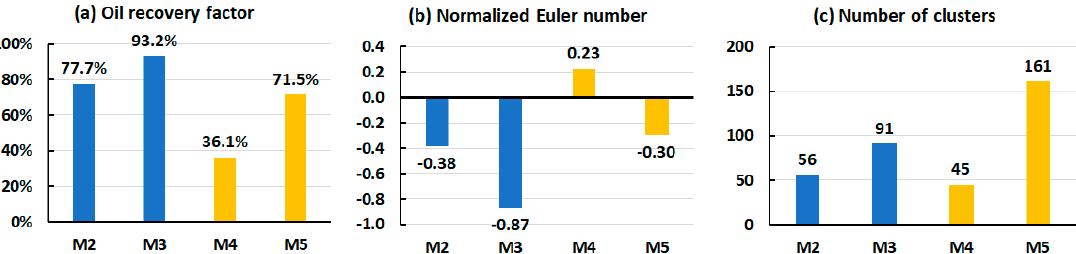
Figure 11. ( a ) Oil recovery, ( b ) normalized Euler number, and ( c ) number of clusters in the post-flooding images of low rate (in blue) and high rate (in yellow) microfluidic experiments. CNCs were used in M2 and M4, and T-CNFs were used in M3 and M5.